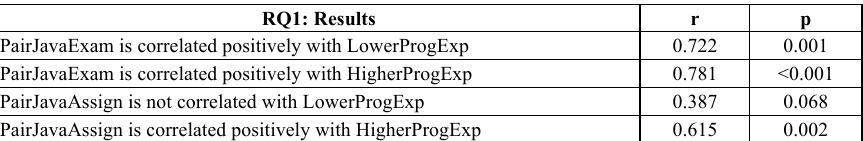
Table 4. Results summary of RQ1 (extended)